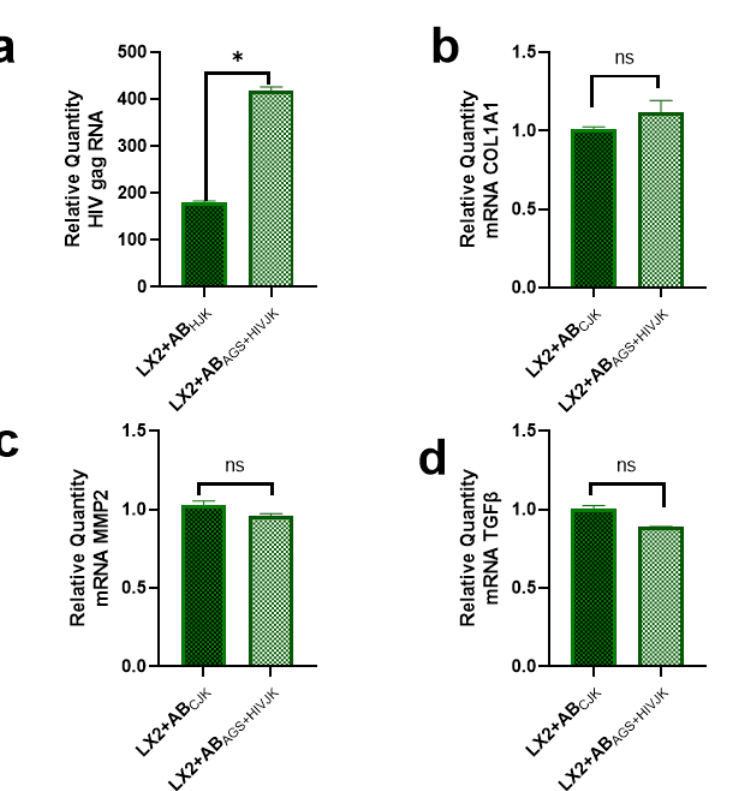
Figure 2. ABs derived from acetaldehyde and HIV-infected Jurkat cells enhance HIV expression but do not trigger profibrotic activation in LX2-cells: RT-PCR quantification of ( a ) HIV gag RNA, ( b ) COL1A1 mRNA, ( c ) MMP2 mRNA, and ( d ) TGF β 1 mRNA. Data are from 3 independent experiments presented as mean ± SEM. Bars with * are significantly different from each other and bars marked ns are not statistically different at p ≤ 0.05.